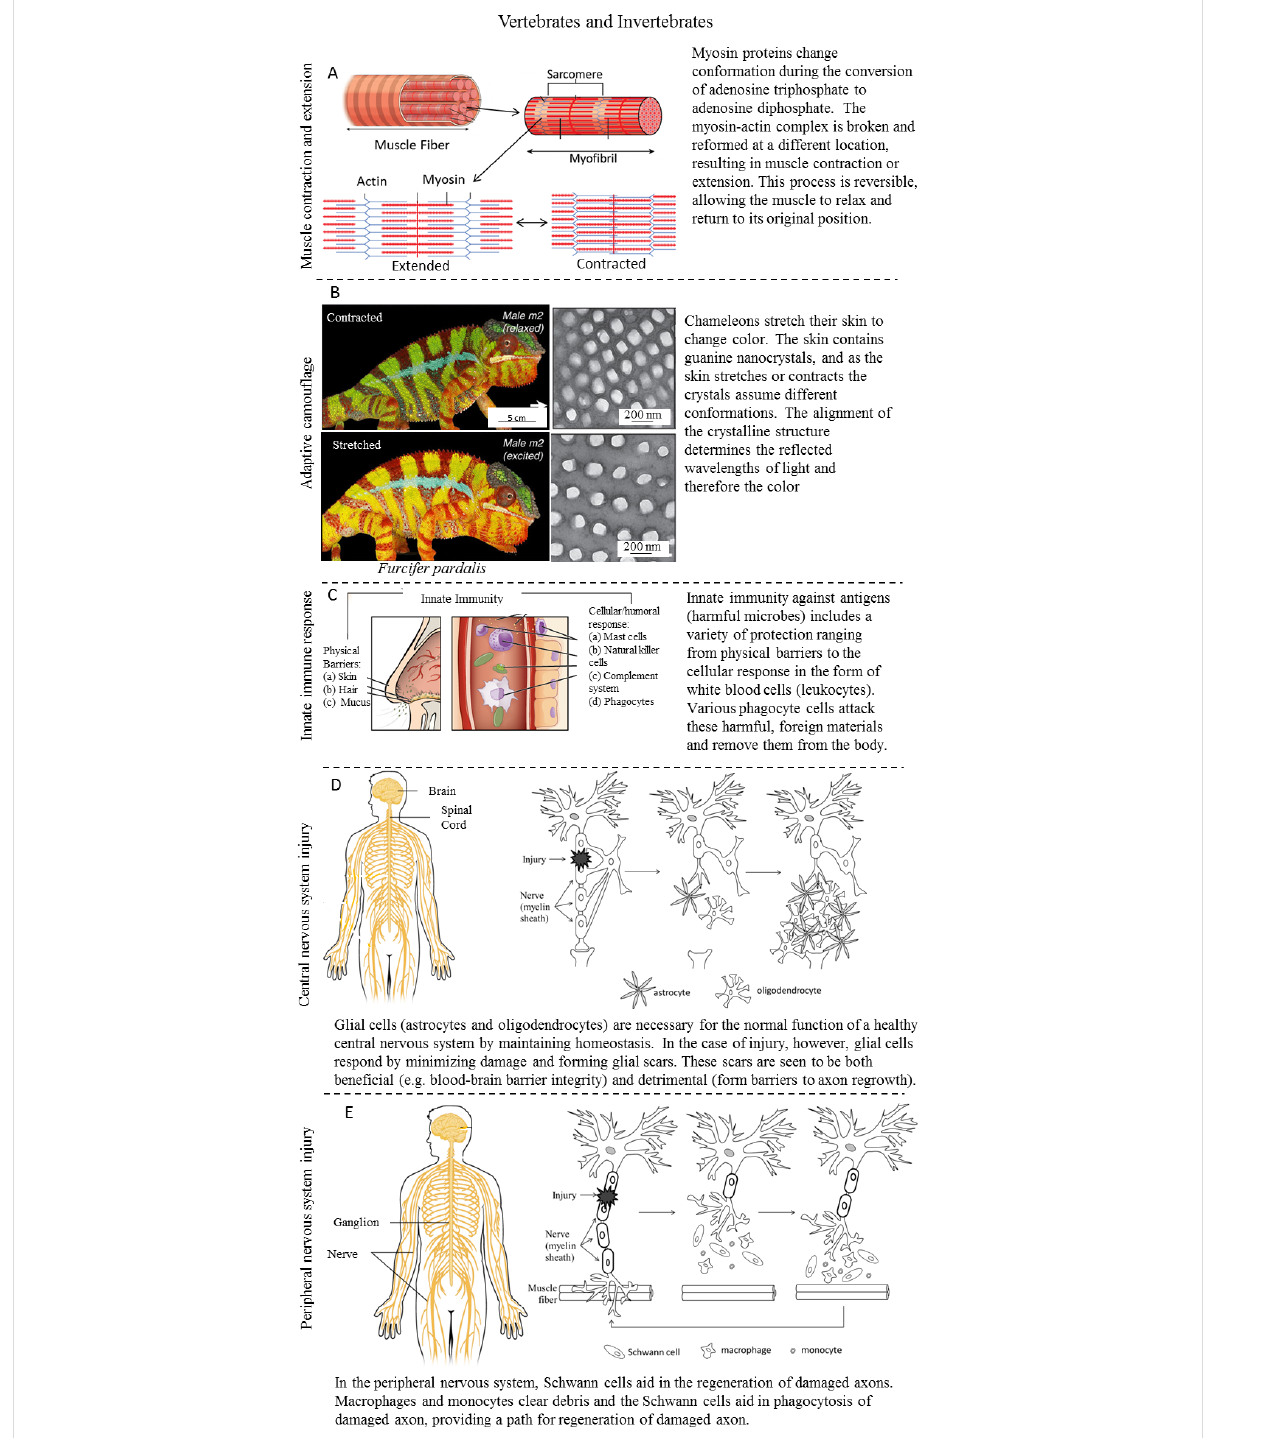
Figure 2: Healing and defense mechanisms shared by vertebrates and invertebrates including (A) muscle extension and contraction, (B) adaptive camouflage, (C) innate immunity, and (D, E) healing of central and peripheral nervous system injuries. (A) The hierarchical structure of muscle is shown, building up from the basic protein components of actin and myosin. Adapted from [39]. (B) Color change in chameleons occurs through re- versible muscle control of guanine nanocrystals in their skin. Adapted from [15]. (C) Innate immunity consists of physical barriers to harmful microbes as well as an internal cellular and humoral response should they gain access to the body. Adapted from [40]. (D) In healing of a central nervous system injury, glial cells in the extracellular matrix quickly form scar tissue to maintain homeostasis, but may prevent axon repair in the process. (E) In healing a peripheral nervous system injury, Schwann cells clear the area around the axons and allow for repair without obstruction. The left images in (D) and (E) were adapted from